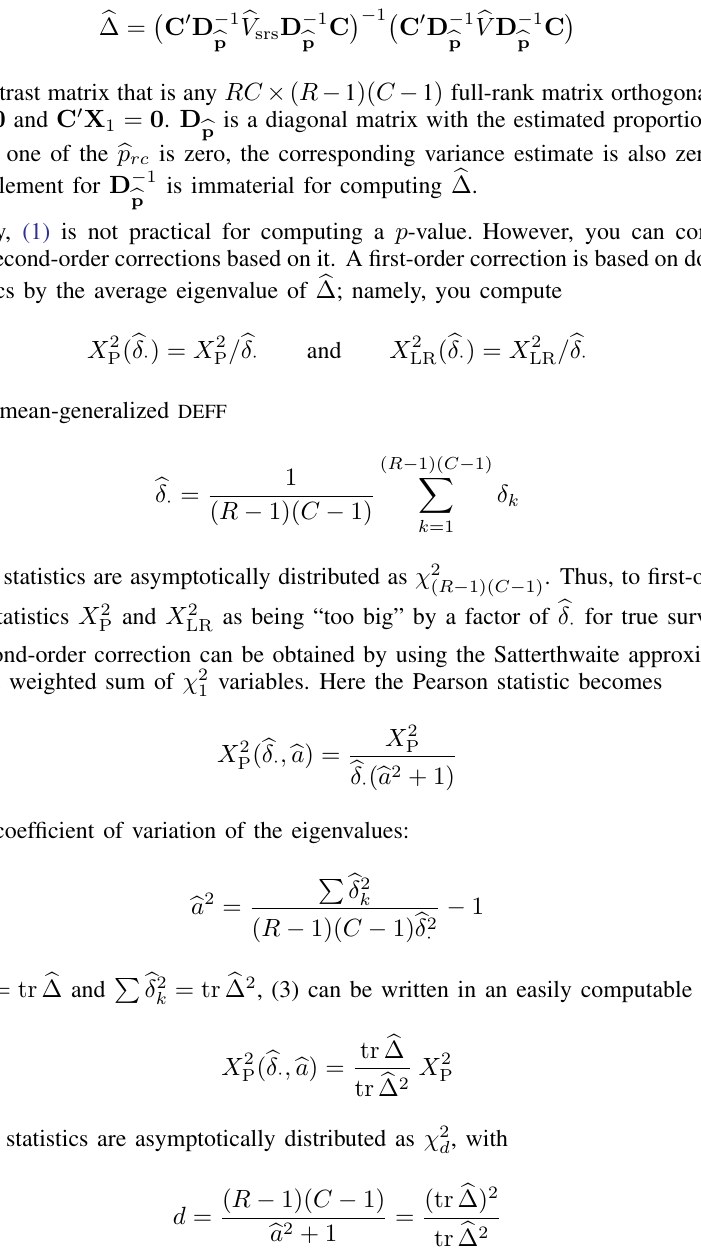
svy: tabulate twoway — Two-way tables for survey data